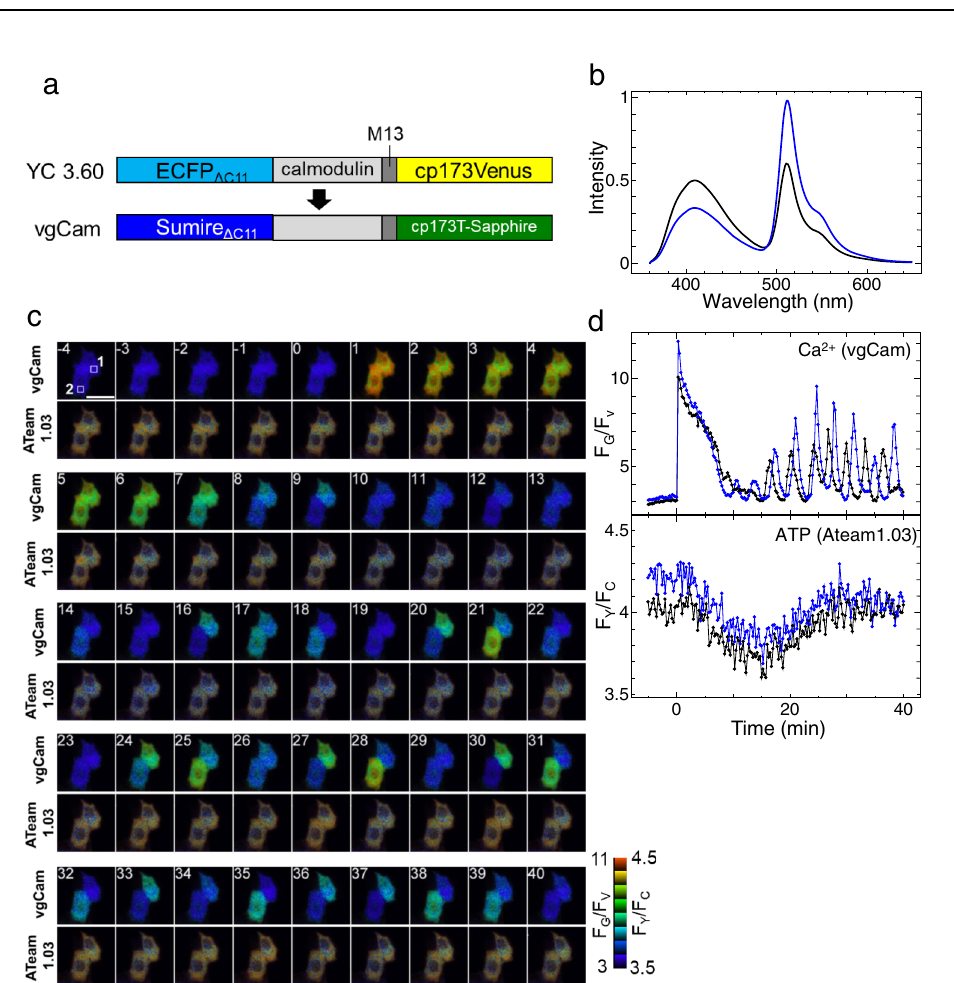
Fig. 2 Sumire-T-sapphire based FRET probe. a Diagram of vgCam construct. b Emission spectra of vgCam in the presence of 20 μ M CaCl 2 (blue) and 10 mM EGTA (black). Spectra data are average measurements of independently prepared samples ( n = 3). c A series of pseudo color ratio images of vgCam and ATeam1.03. Scale bar: 40 μ m. d Time course of fl uorescence intensity ratio of vgCam and ATeam1.03 inside ROI1 (black) and ROI2 (blue) depicted in the top-left image of c . 100 μ M histamine was added at time